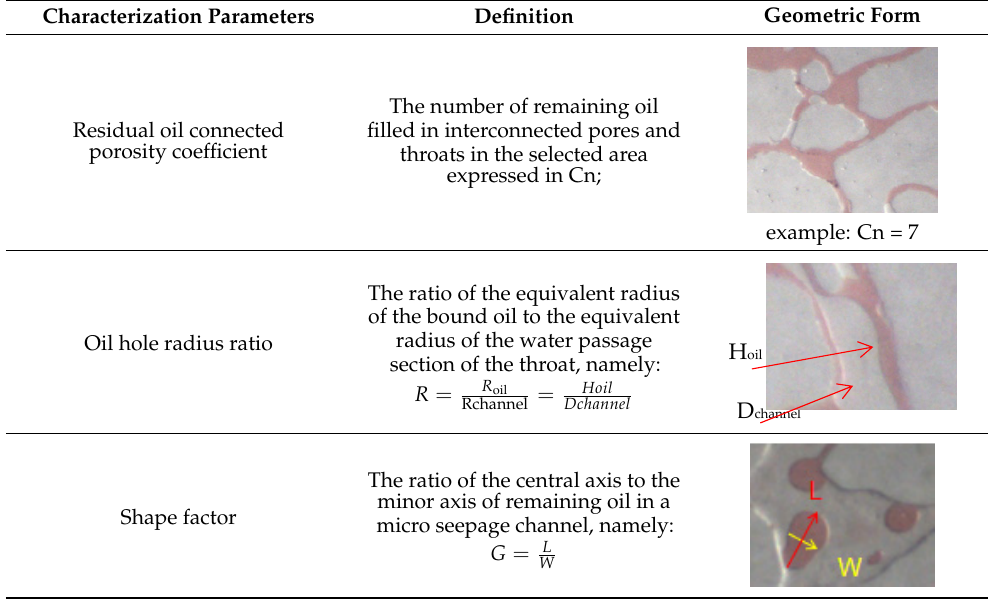
Table 2. Characterization method of microscopic residual oil formation mechanism.